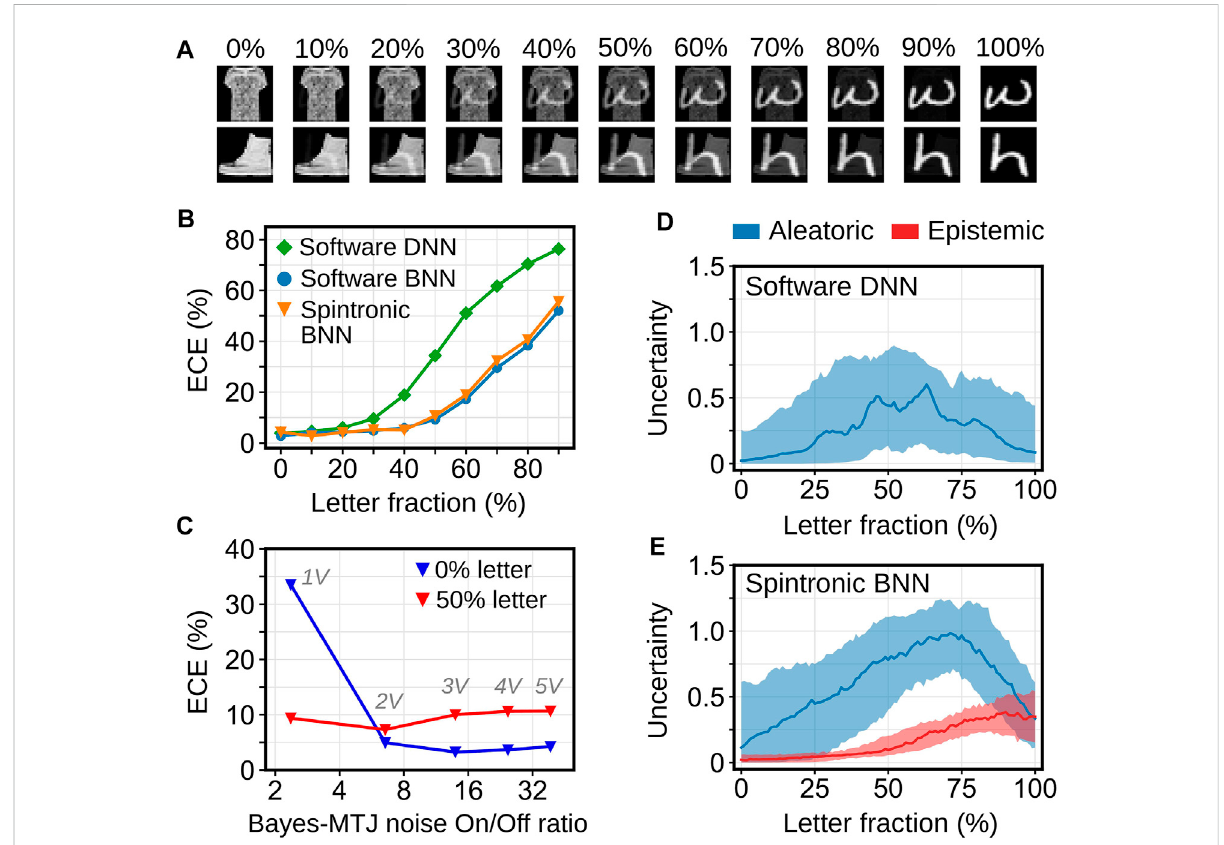
FIGURE 5 (A) Continuous transformation from Fashion MNIST to EMNIST-Letters images by varying the letter fraction, (B) ECE vs. letter fraction for the software DNN, software BNN, and spintronic implementation of the BNN, (C) Dependence of the ECE on the Bayes-MTJ noise On/Off ratio ( δ G BMTJ,max / δ G BMTJ,min ). The maximum value of V bi needed to achieve the On/Off ratio is labeled. (D) Uncertainty vs. letter fraction predicted by the DNN, (E) Uncertaintyvs.letterfractionpredictedbytheBNN,decomposedintoaleatoricandepistemicuncertainty components. Uncertainties are in units of information entropy and the shaded regions contain the middle 50% of 100 FMNIST-to-Letters transformations